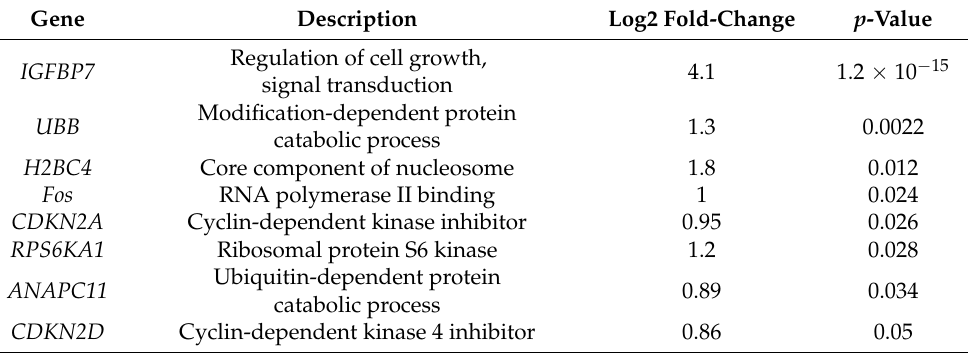
Table 4. Differentially expressed genes in the senescence-associated secretory phenotype